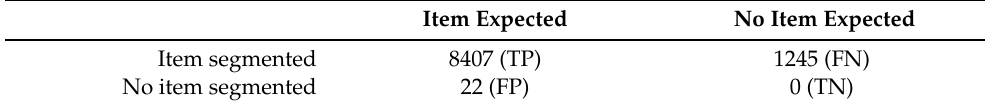
Table 4. Confusion matrix based on 9652 sampled items.